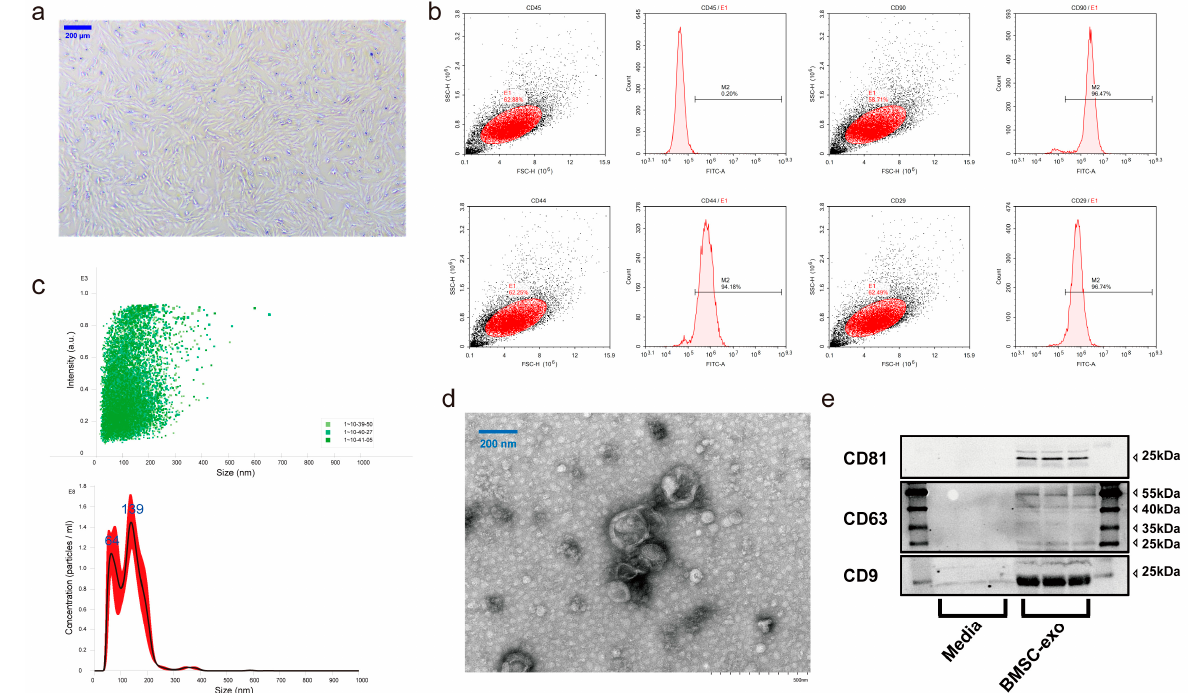
Figure 2. Isolation and characterization of BMSCs and BMSC-exos. ( a ) BMSCs again exhibited a typical spindle-shaped and fibroblast-like morphology in the view. The scale bar is 100 µ m. ( b ) BMSC-specific surface markers such as CD45, CD90, CD44, and CD29 were measured by flow cytometry. ( c ) Determination of BMSC-exos particle size using NTA. ( d ) TEM observation of BMSC- exos morphology. ( e ) Western blot of exosome biomarkers.